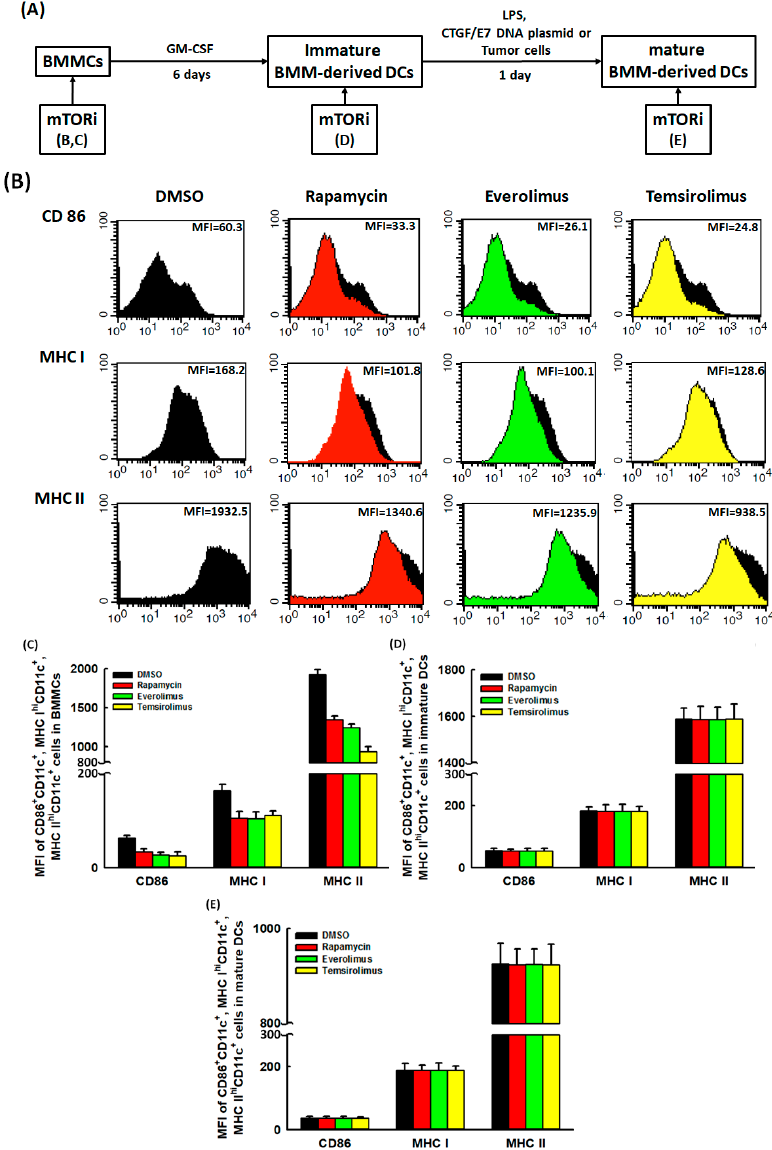
Figure 1. Influence of mTORi on the DC maturation markers expressed on BMMCs, immature BMM-derived DCs and mature BMM-derived DCs. ( A ) Schematic diagram showing the process of in vitro developing DCs from murine BMMCs. ( B ) Representative figures of flow cytometric analyses for the MFIs of CD86 + CD11c + , MHC I hi CD11c + , and MHC II hi CD11c + cells in BMMCs treated with/without mTORi. ( n = 3) ( C ) Bar figures showed the MFIs of CD86 + CD11c + , MHC I hi CD11c + , and MHC II hi CD11c + cells in BMMCs treated with/without mTORi. The MFIs of CD86 + CD11c + ( p = 0.016), MHC I hi CD11c + ( p = 0.024), and MHC II hi CD11c + ( p = 0.018) cells were lower in mTORi-treated BMMCs than those in non-mTORi-treated groups. ( n = 3) ( D ) Bar figures showed the MFIs of CD86 + CD11c + , MHC I hi CD11c + , and MHC II hi CD11c + cells in immature BMM-derived DCs treated with/without mTORi. The MFIs of CD86 + CD11c + , MHC I hi CD11c + , and MHC II hi CD11c + cells did not show di ff erences between mTORi-treated immature BMM-derived DCs and non-mTORi-treated groups. ( n = 3) ( E ) Bar figures showed the MFIs of CD86 + CD11c + , MHC I hi CD11c + , and MHC II hi CD11c + cells in mature BMM-derived DCs treated with / without mTORi. The MFIs of CD86 + CD11c + , MHC I hi CD11c + , and MHC II hi CD11c + cells did not show di ff erences between mTORi- and non-mTORi-treated mature BMM-derived DCs. ( n =